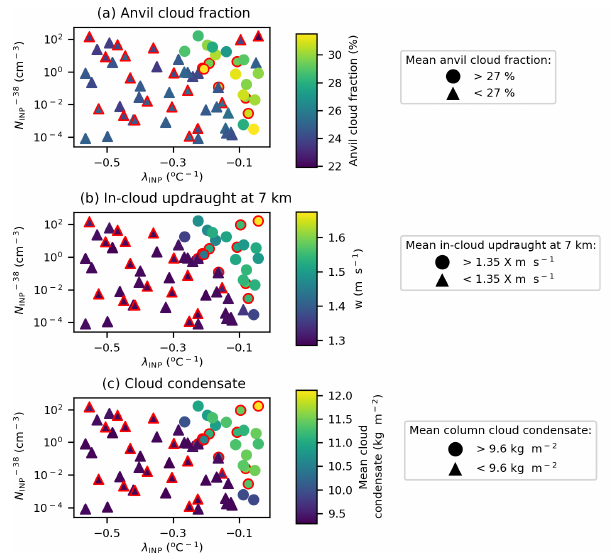
Figure 13. Regime change in anvil cloud fraction and driving pro- cesses. Variation in anvil cloud fraction (a) , in-cloud updraught speed at 7km (b) , and total cloud water path (c) due to variation in λ INP and N INP − 38 . Marker colours indicate the value of the mean peak anvil cloud fraction (a) , in-cloud updraught speed at 7km (b) , and total cloud water path (c) . Circular markers indicate a cloud fraction above 27% (a) , a mean in-cloud updraught speed above 1.35ms − 1 (b) , and a water path over 9.6kgm − 2 (c) . Simu- lations with a HM-eff above 600splintersmg − 1 are indicated with a red outline. Panel (a) is the average of the cloud property between 150 and 240min (anvil stage) of the simulation, while panels (b) and (c) are the average of the relevant cloud property between 60 and 180min (convective stage) of the